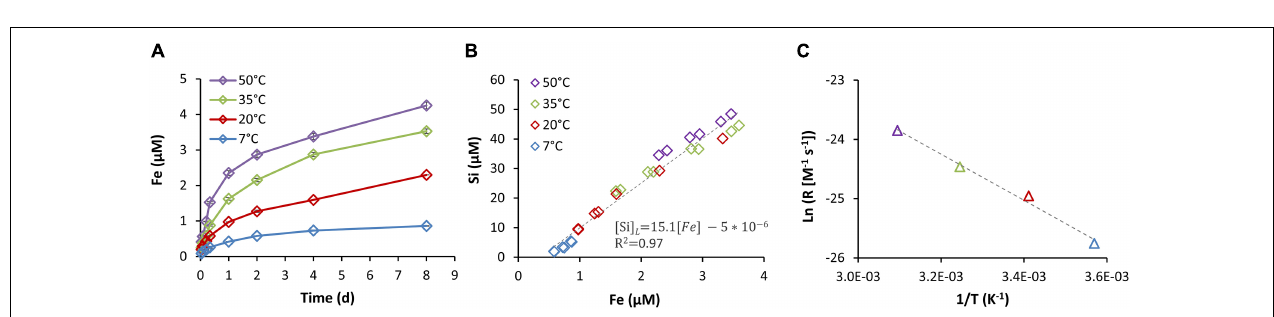
FIGURE 5 | Concentration of Si (A) and Al (B) as a function of Fe concentration. The data includes all time points from experiments with 9, 30, and 90 µ M DFOB. Data from 0–8 h (Early) is presented in red and data from 24–192 h (Late) in green. The marker size indicates the applied DFOB concentration. Linear trends were fitted separately for the early and late stages and the fitting equations are presented below the graphs. The early stage correlation between Al and Fe was very weak ( R 2 = 0.15) and is therefore not displayed.